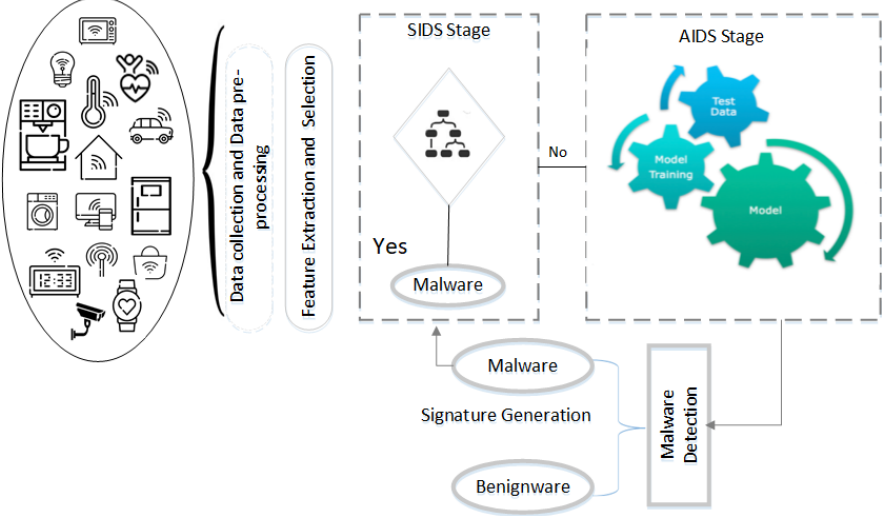
Figure 2. Anomaly Intrusion Detection System for the IoT